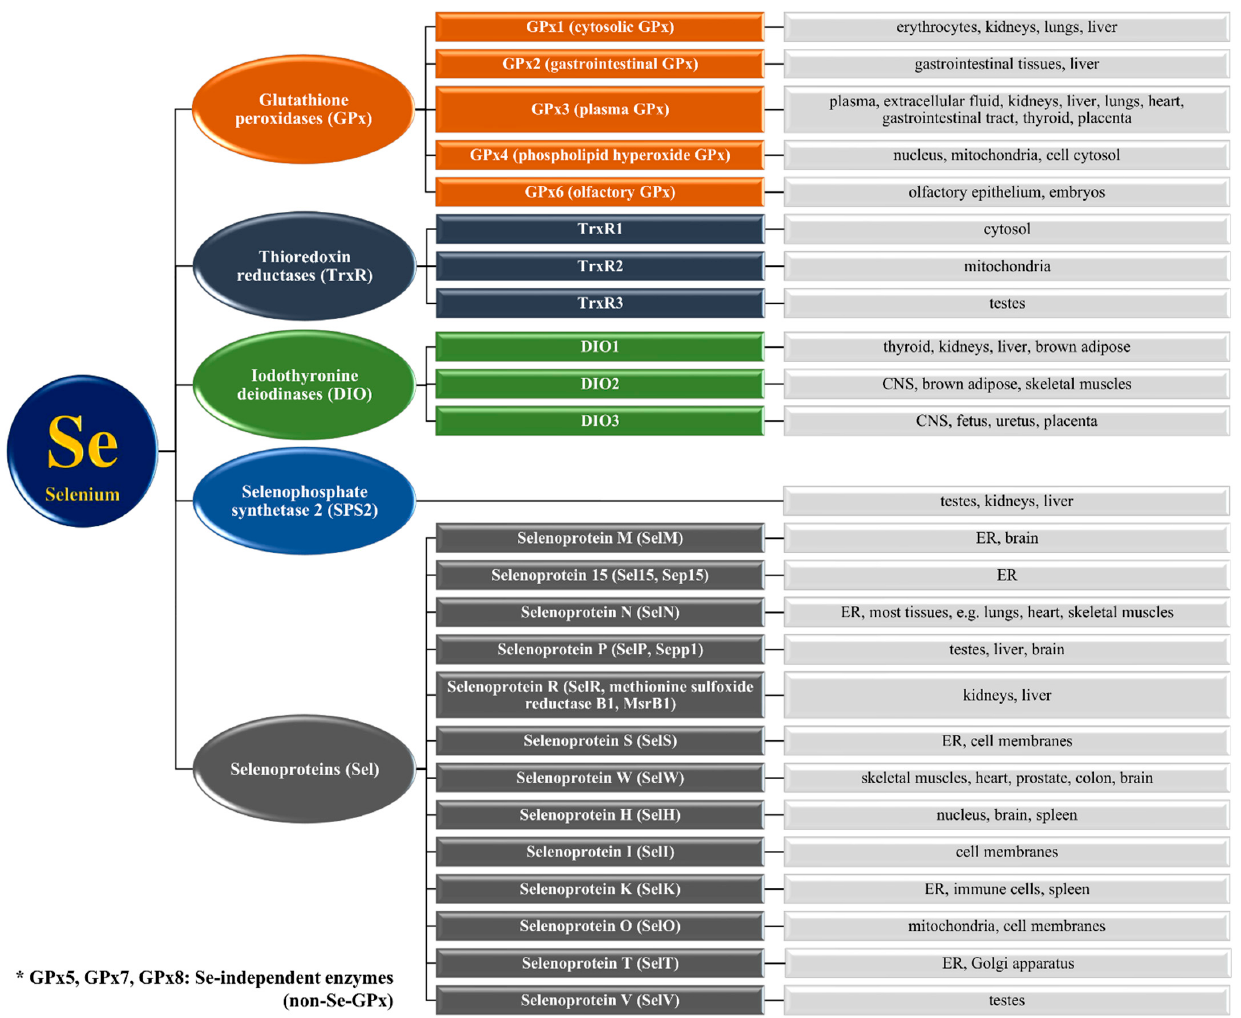
Figure 2. Selenoprotein families and their localization in the human body [2,82,85,86]. ER—endoplasmic reticulum, CNS—central nervous system.